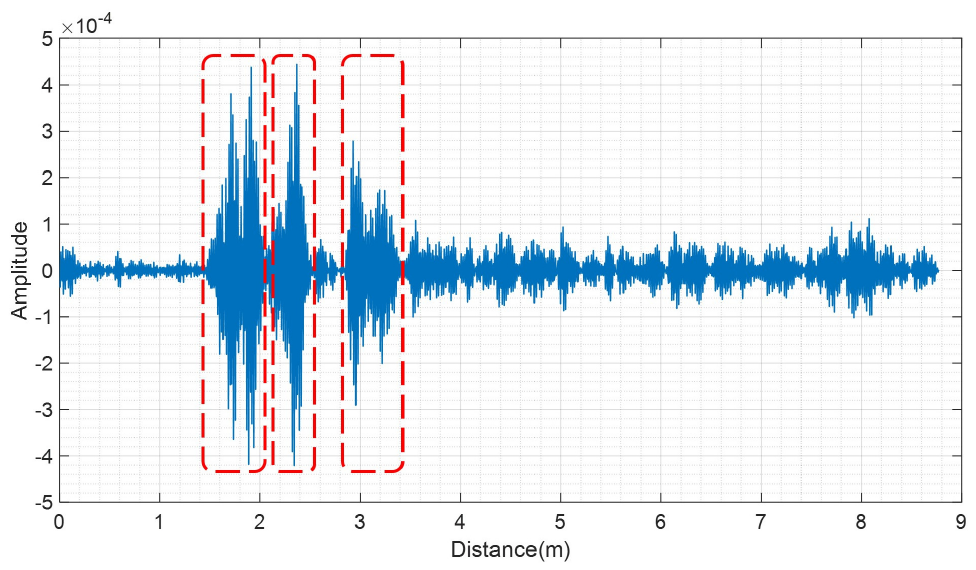
Figure 3. Clutter removed signal when a person is 2 m from the